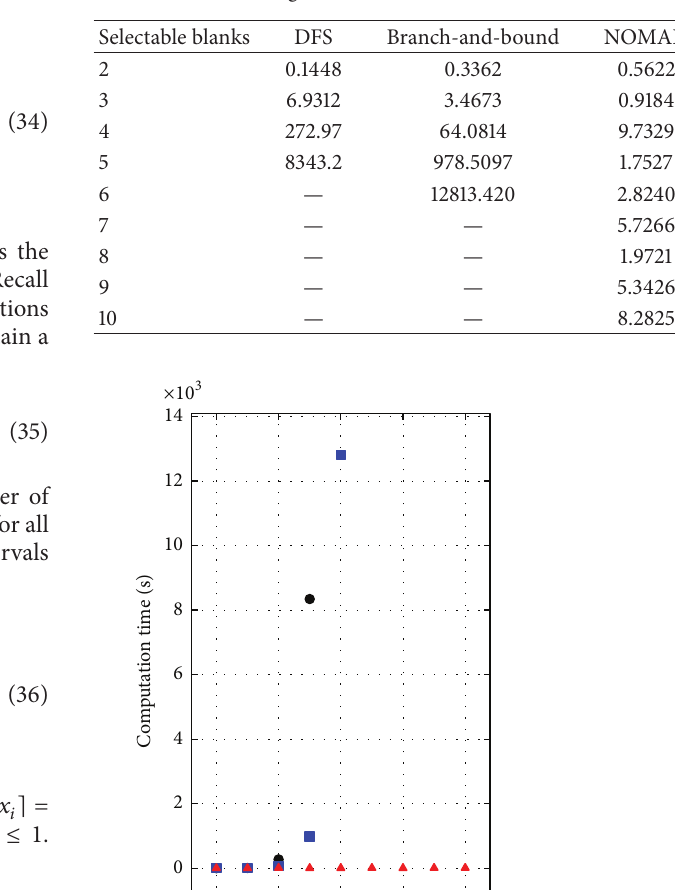
Table 4: Algorithm execution times (seconds).